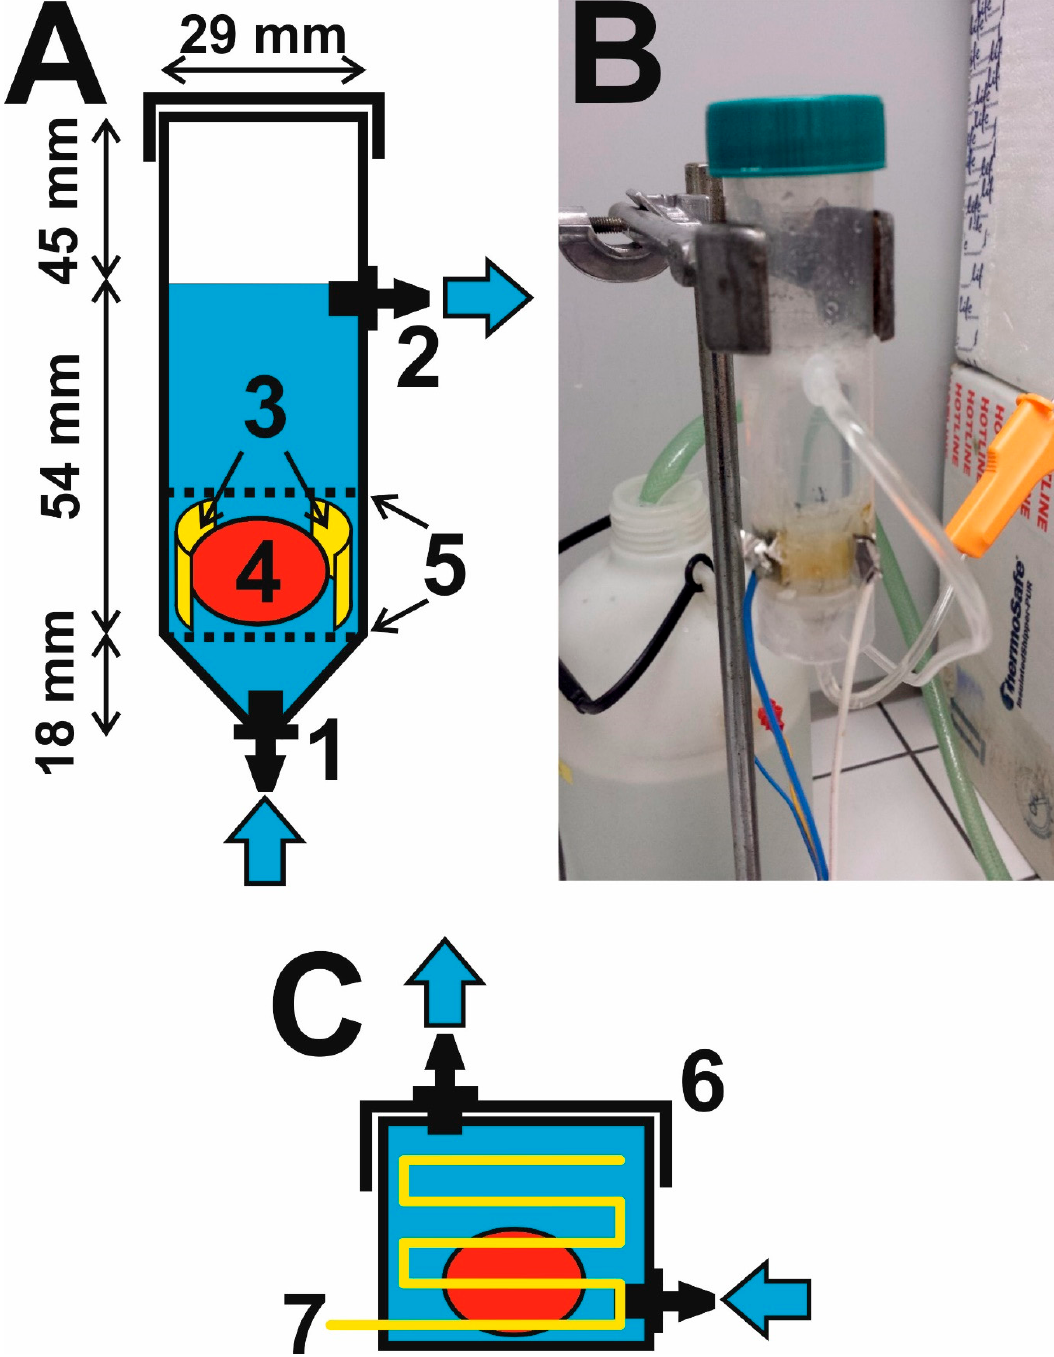
Figure 1. Scheme of the electrophoretic flow-through cell made from the polyethylene (PE) vessel ( A ): 1—inlet and 2—outlet small fitting for connecting tubing, 3—Pt-electrodes, 4—hydrogel tissue, 5—plastic meshes; ( B ) photograph of the cell; ( C ) original flow-through cell of CLARITY apparatus for comparison: 6—PE vessel with flat bottom, 7—Pt-electrodes created from rectangular-shaped wires. (i) Two holes with a diameter of 4 mm were drilled into the top of the conical base and the vertical wall cca 45 mm from the upper edge of the vessel. Plastic connectors for connecting rubes, a small Luer fitting for 1/8” tubing (the Luer valve assortment set, from World Precision Instruments, Saratosa, FL, USA, was used), were forced into the openings; the drilled hole must be slightly smaller than the diameter of the connector so that a water-tight connection is formed after pressing it in. The